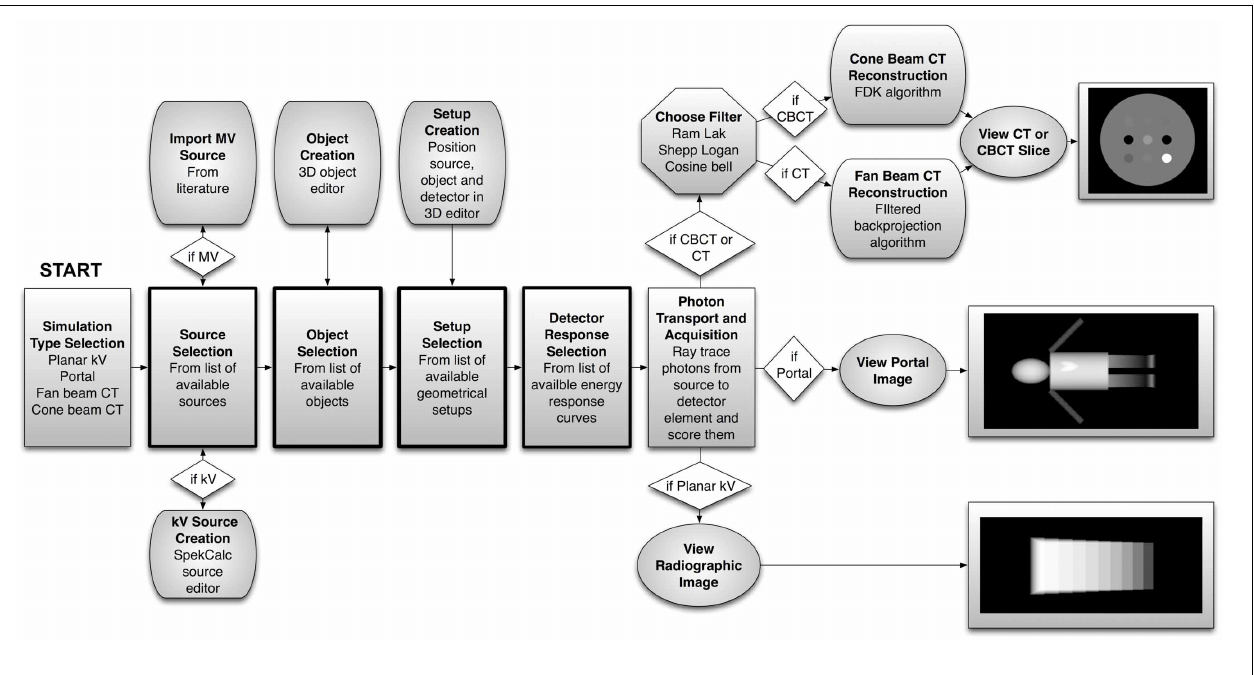
FIGURE 1 | Flowchart representing the modules of ImaSim and the logical flow linking them. A simulation setup starts at the left with Simulation Type Selection and ends with a simulated medical image at the